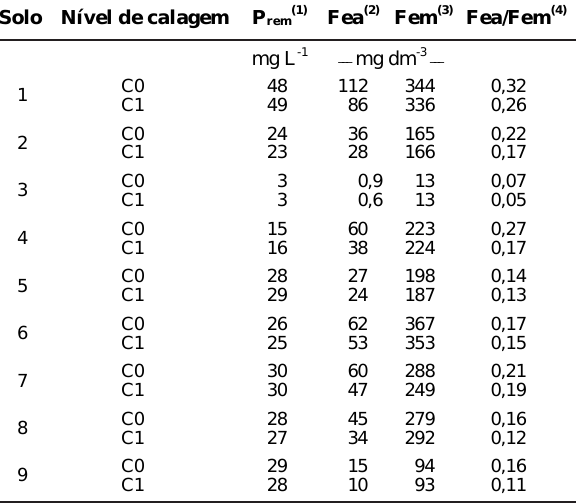
para os solos 2 e 8, embora o solo 4 tenha